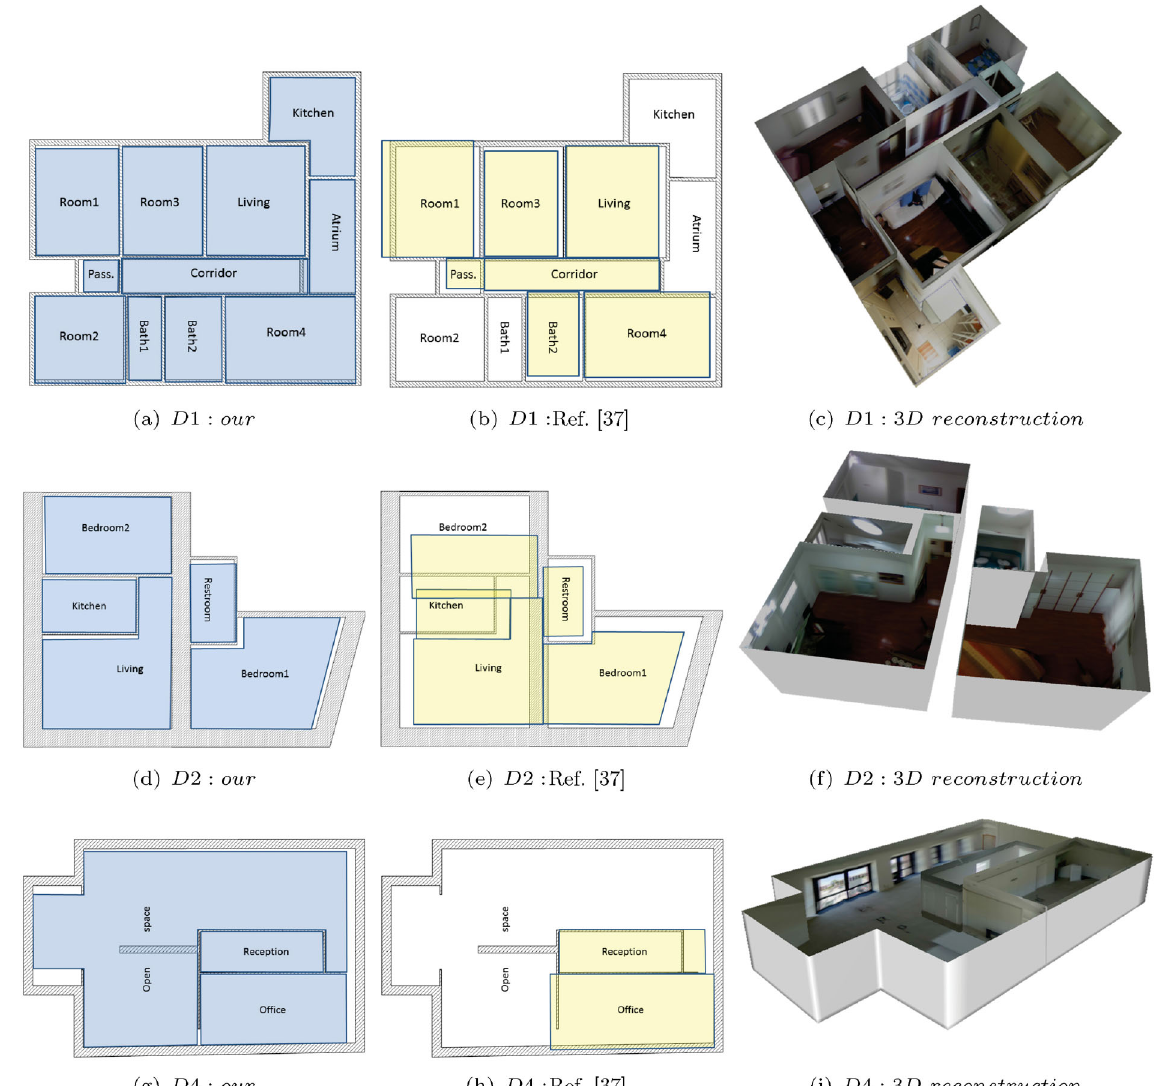
Fig. 11 Recovered footprint and 3D models versus ground truth floor plan. Grey footprint: real, metrically scaled, ground truth. Left: results of our method. Center: results from the multi-room approach of Pintore et al. [4]. Right: our final textured 3D floor plan. Ceilings and septal wall have been removed from the 3D reconstruction to assist